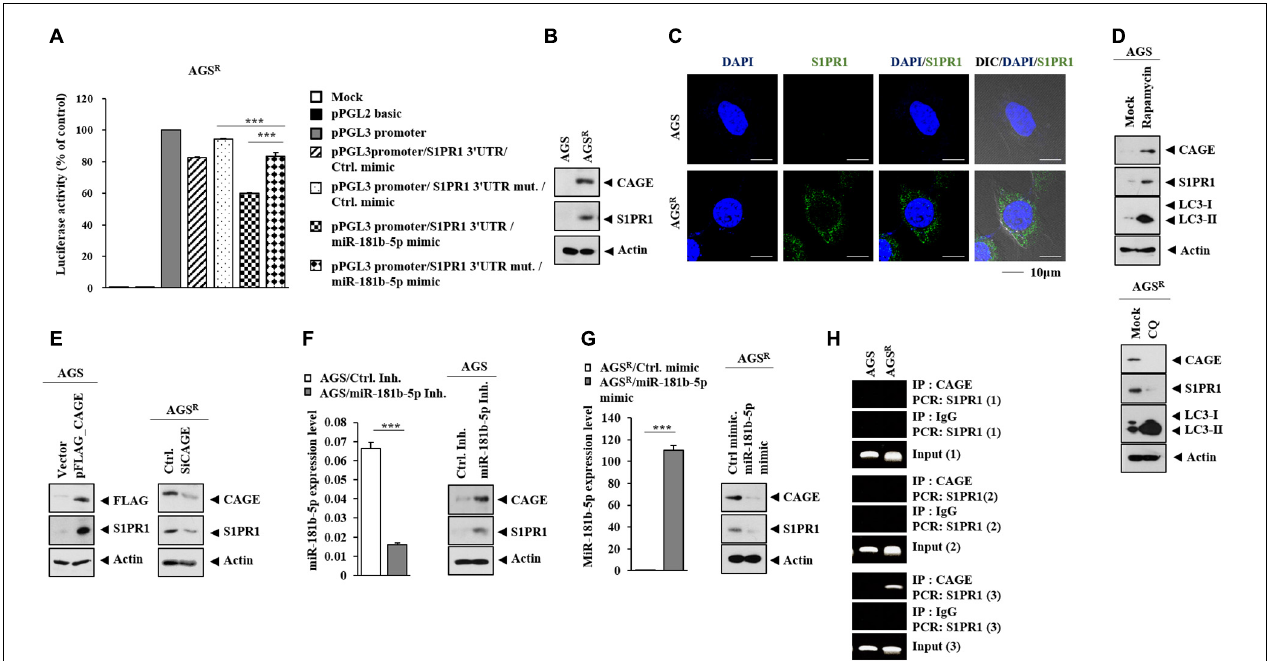
FIGURE 9 | SIPR1 serves as a target of miR-181b-5p. (A) After 48 h of transfection with the indicated construct (each at 1 µ g) and/or mimic (each at 10 nM), luciferase activity assays were performed. ***, p < 0.001. Average values of three independent experiments are shown. (B) Immunoblot was performed. Representative blots of three independent experiments are shown. (C) Cytoplasmic localization of S1PR1 is shown. (D) The indicated cancer cells were treated with or without rapamycin (5 µ M) or CQ (100 µ M) for 24 h. Representative blots of three independent experiments are shown. (E) After 48 h of transfection, immunoblot was performed. Representative blots of three independent experiments are shown. (F) After 48 h of transfection, qRT-PCR and immunoblot were performed. ***, p < 0.001. Average values of three independent experiments are shown. (G) After 48 h of transfection, qRT-PCR and immunoblot were performed. ***, p < 0.001. Average values of three independent experiments are shown. (H) ChIP assays were performed as